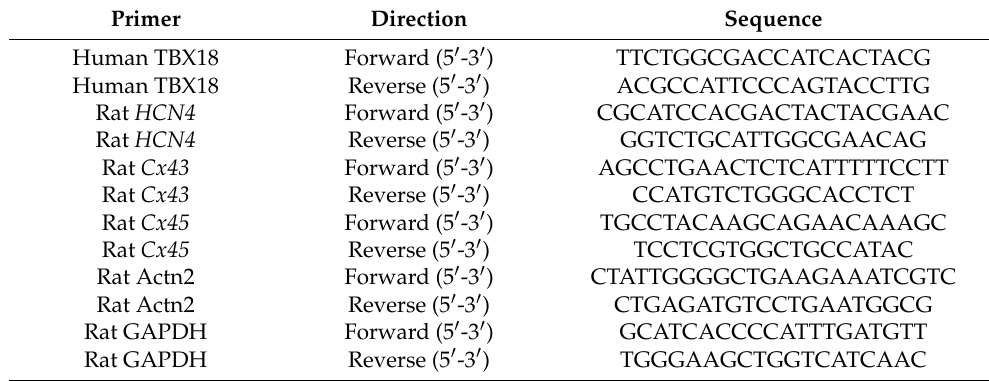
Table 1. Primers used for RT-PCR protocol to measure fold changes in synthesized cDNA.